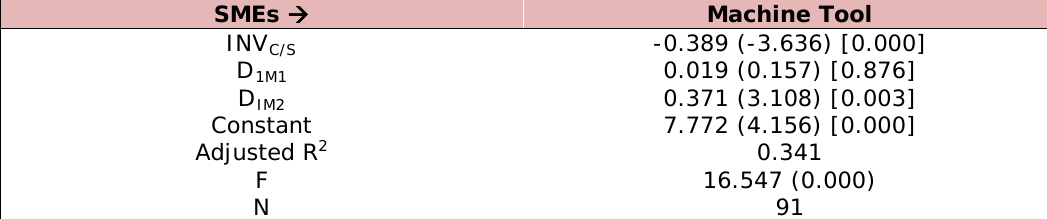
Table 15. “Regression Analysis of ITR with Inventory Cost per Sale and IM Practices (Dependent Variable: